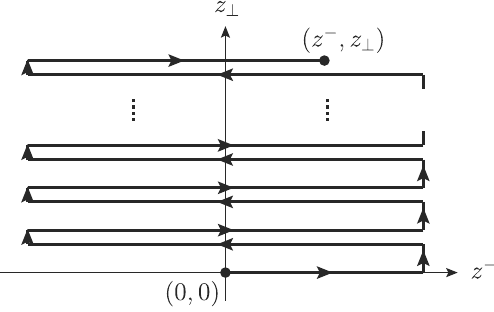
Fig. 3 Light-front Wilson line W η ( z , 0 ) for an arbitrary value of the parameter η ∈ [− 1 , 1 ] . For advanced ( η = + 1) or retarded ( η = − 1) boundary condition, the path reduces to a simple